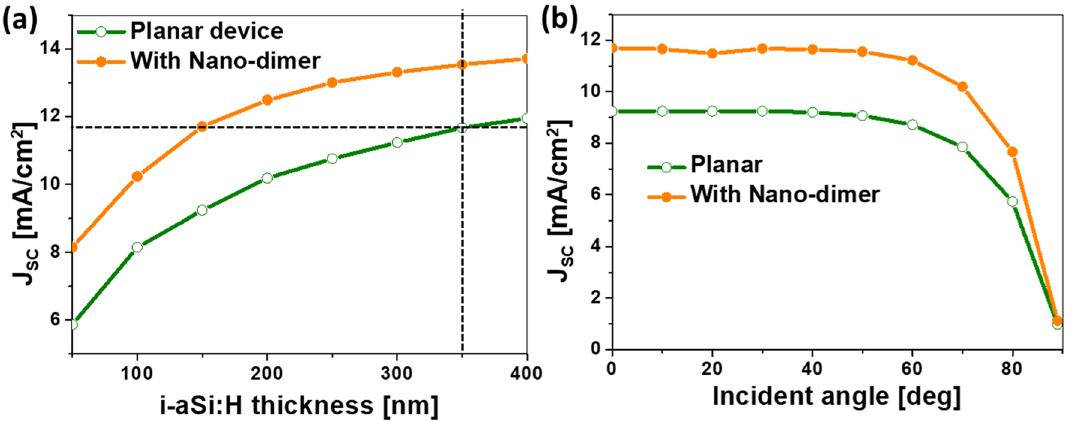
Figure 5. ( a ) Variation of the short-circuit current, J SC , for the optimum design (filled circles) and the unmodified planar cell (open circles) as a function of the thickness of the active layer, t i − aSi : H . ( b ) Short-circuit current as a function of the angle of incidence for the optimum design of the cell plus the nano-dimer (filled circles), and the planar solar cell (open